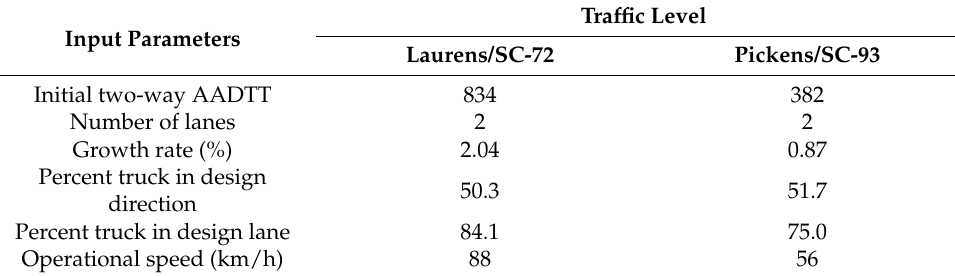
Table 1. Traffic inputs for the flexible pavement design.